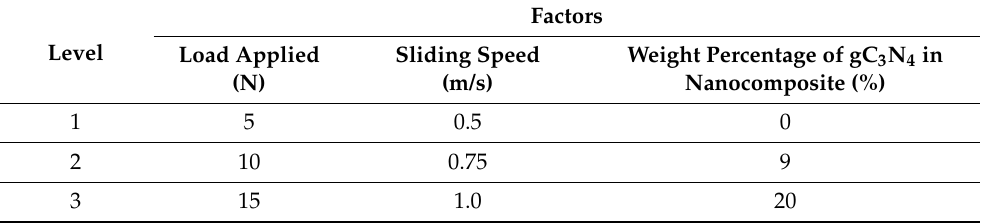
Table 3. Control factors with respective levels for analyzing wear behavior of the coating material. Factors Level Load Applied Sliding Speed Weight Percentage of gC 3 N 4 (N) (m/s)